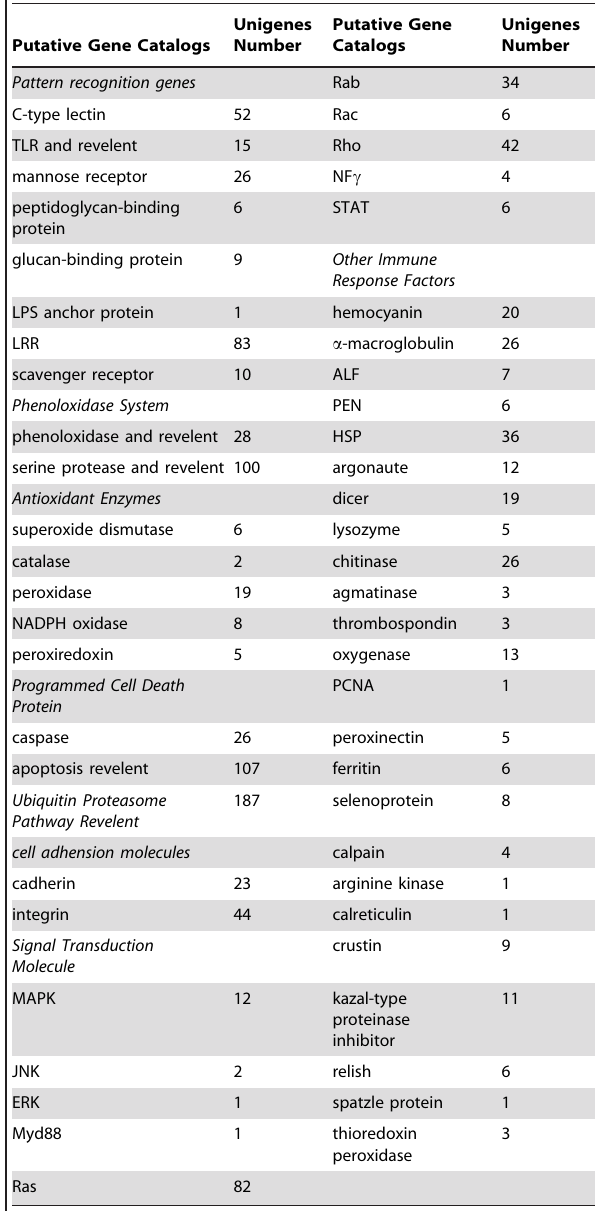
Unigenes Number